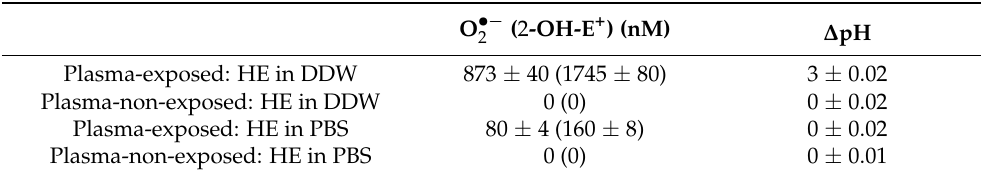
Table 3. Plasma generated O •− in DDW and PBS; values are averages from 5 repeats, with standard 2 deviation around